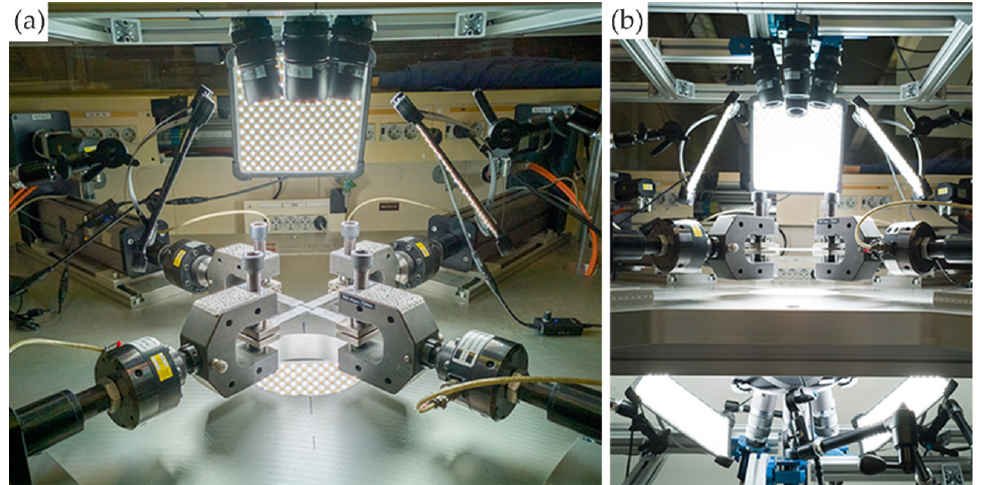
Figure 1. ( a ) Biaxial setup, ( b ) System for digital image correlation with lighting and cameras. The steel alloy X5CrNi18-10 (EN 10088-3) is the subject of the investigation, and speci- mens were cut from sheets with a 4 mm thickness. The biaxial X0-specimen in Figure 2a–c includes four notched sections that are tilted at 45 ◦ and a central hole. Displacement fields were examined in this area by DIC. The specimen had a thickness of 2 mm at its thinnest points and measured 240 mm along each axis. The depth of the notches was 1 mm. The test routine considered biaxial loading of the specimen by F 1 and F 2 and the movement of the red dots (Figure 2d), u 1.1 and u 1.2 in 1-direction and u 2.1 and u 2.2 in 2-direction served as displacement measure ∆ u ref .1 = u 1.1 − u 1.2 and ∆ u ref .2 = u 2.1 − u 2.2 . The loading paths of this series can be seen in Figure 2e. In the first case, the specimen was proportionally loaded by F 1 : F 2 = 1 : − 0.5 and a maximum load of F 1 = − 2 F 2 = 14.0 kN. For the non-proportional case, the specimen was firstly loaded by F 1 up to F 1 = 9.5 kN, then it was kept constant and subsequently in axis 2, the loading F 2 decreased to F 2 = − 5.0 kN. The point of axis switch takes place at 20% of the fracture displacement of the corresponding proportional experiment F 1 : F 2 = 1 : 0. The influence of the first non-proportional section on the overall experiment is thus small compared to an axis switch shortly before fracture. The last step of the load path is proportional loading up to